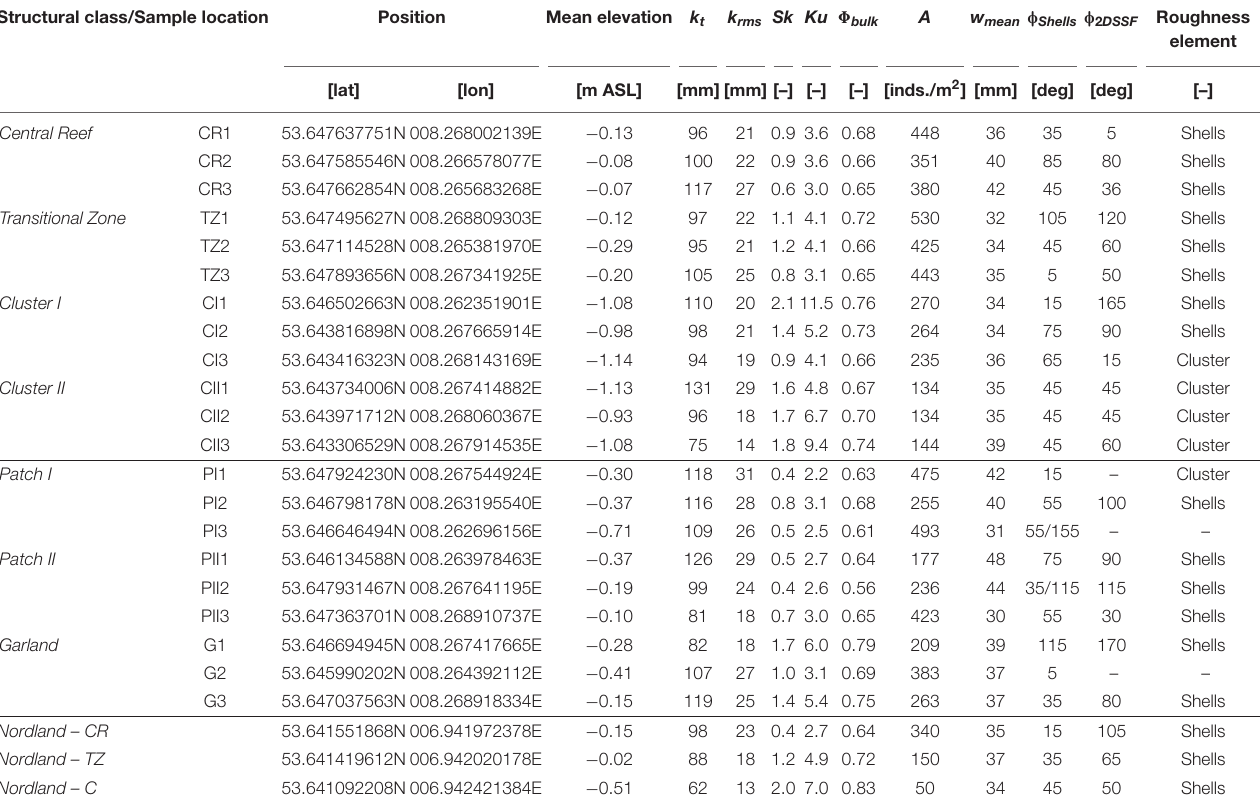
TABLE 2 | Summary of the results of the statistical analysis, where k t is the total roughness height, k rms is the root-mean-square roughness height, Sk is the skewness, Ku is the kurtosis, (cid:56) bulk is the bulk porosity, A is the abundance, w mean is the mean width of the oyster shells, φ Shells is the major direction of the oyster shells and φ 2 DSSF is the orientation of the mean axis of the area of high correlation resulting from the second-order structure